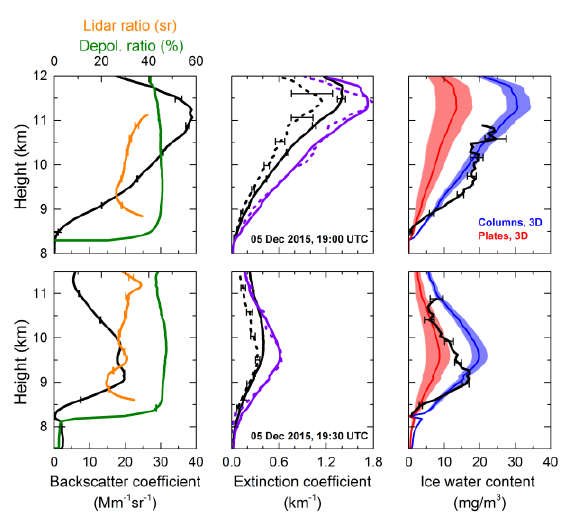
Figure 1. Retrieval results for two observations of 3D cirrus. (left) Particle backscatter coefficient, lidar ratio and particle depolarization ratio. (middle) Particle extinction coefficient as measured with the wide-FOV receiver (black dashed curve) and with the narrow-FOV receiver (black solid curve), and after the correction for multiple scattering (colored curves). (right) Measured (black curve) and retrieved ice water content (colored curves). Either 3D plates or columns are assumed, aspect ratios are 0.08 and 2.5, respectively. Shaded areas are supposed to illustrate natural variability. Lidar data integration time is 20 min, bars indicate statistical errors. The wide-FOV receiver has a telescope diameter four times smaller than the narrow-FOV receiver, which explains the different noise levels of the extinction